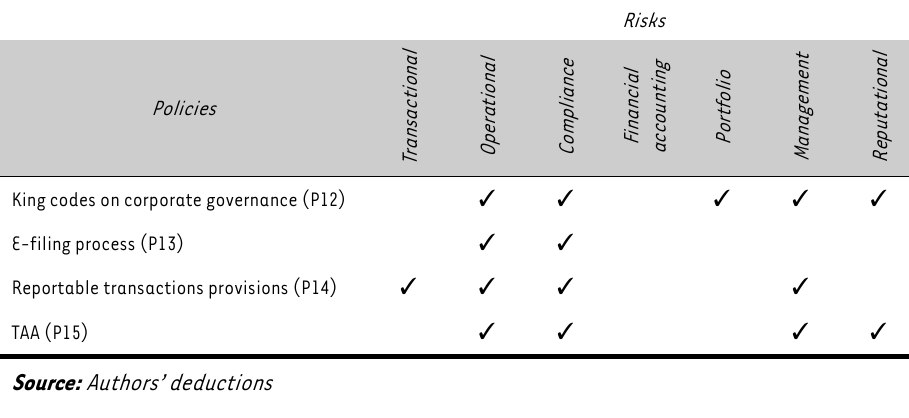
TABLE 4: Summary of policy